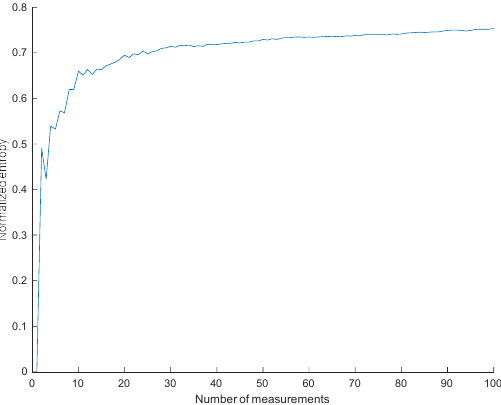
Figure 7. Convergence of the minimum entropy to its asymptotic value for responses of RND cells. Table 2. Basic NIST tests evaluated for the sequences provided by RND cells.